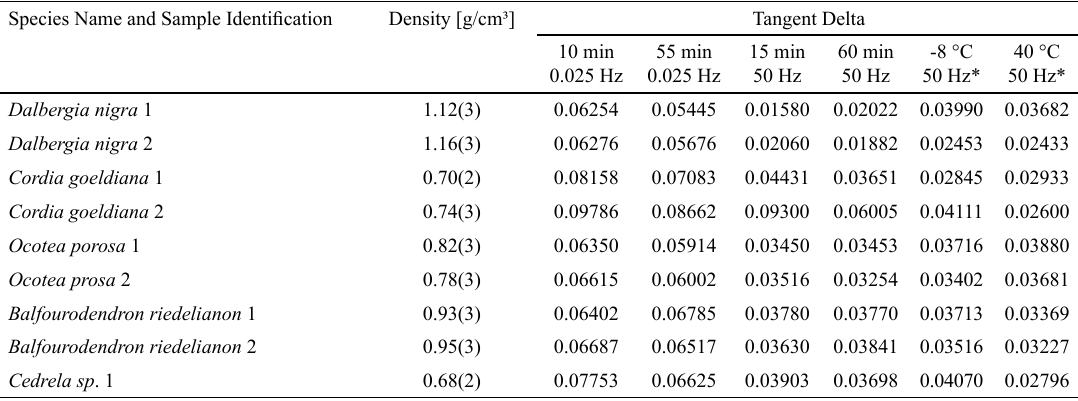
Table 2. Tangent Delta spectroscopy and variance with temperature